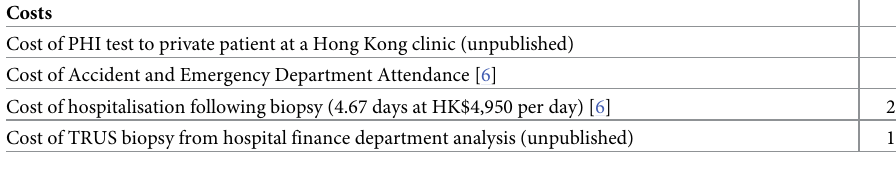
Table 1. Inputs to the model and data sources. Clinical data from Chiu et al study [2] Cohort size–men recruited between April 2008 and July 2015 with PSA 4-10ng/mL and negative DRE— undergoing biopsy Prevalence of high-grade cancer in men with PHI score < 25 (1/192) 0.5% Prevalence of any grade cancer in men with PHI score < 25 (7/192) 3.6% Prevalence of high-grade cancer in men with PHI score 25–35 (2/225) 0.9% Prevalence of any grade cancer in men with PHI score 25–35 (17/225) 7.6% Prevalence of high-grade cancer in men with PHI score 35–55 (9/131) 6.9% Prevalence of any grade cancer in men with PHI score 35–55 (30/131) 22.9% Prevalence of high-grade cancer in men with PHI score > 55 (4/21) 19.0% Prevalence of any grade cancer in men with PHI score > 55 (8/21) 38.1% Prevalence of high-grade cancer in full cohort (16/569) 2.8% Prevalence of any grade cancer in full cohort (62/569) 10.9% Clinical data from retrospective analysis of Chiu et al cohort (unpublished) Proportion of patients attending Accident and Emergency after biopsy (39 patients from 569 undergoing biopsy) Proportion of patients hospitalised after Accident and Emergency attendance (15 patients from 569 undergoing biopsy) Mean length of stay in hospital following adverse event after biopsy 4.67 Costs HK$ Cost of PHI test to private patient at a Hong Kong clinic (unpublished) 3,000 Cost of Accident and Emergency Department Attendance [6] 1,300 DRE–Digital Rectal Examination, PHI–Prostate Health Index, TRUS–Transrectal